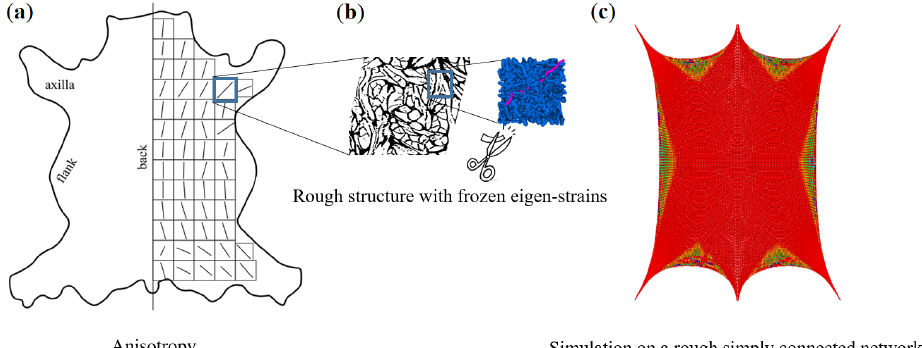
Figure 16. Hypothesis for a hide to be a connected network of locally differently prestressed fiber- bundles. ( a ) A schematic orientation of long fiber bundles under introduced pulling directions; ( b ) A selected long-fiber network turns to an isotropic meso-structure due to cutting during the preparation of CT-specimens; ( c ) Simulations of a frozen pre-stress in a fully connected network due to fixation at six directions in an animal (local fiber reorientation can be